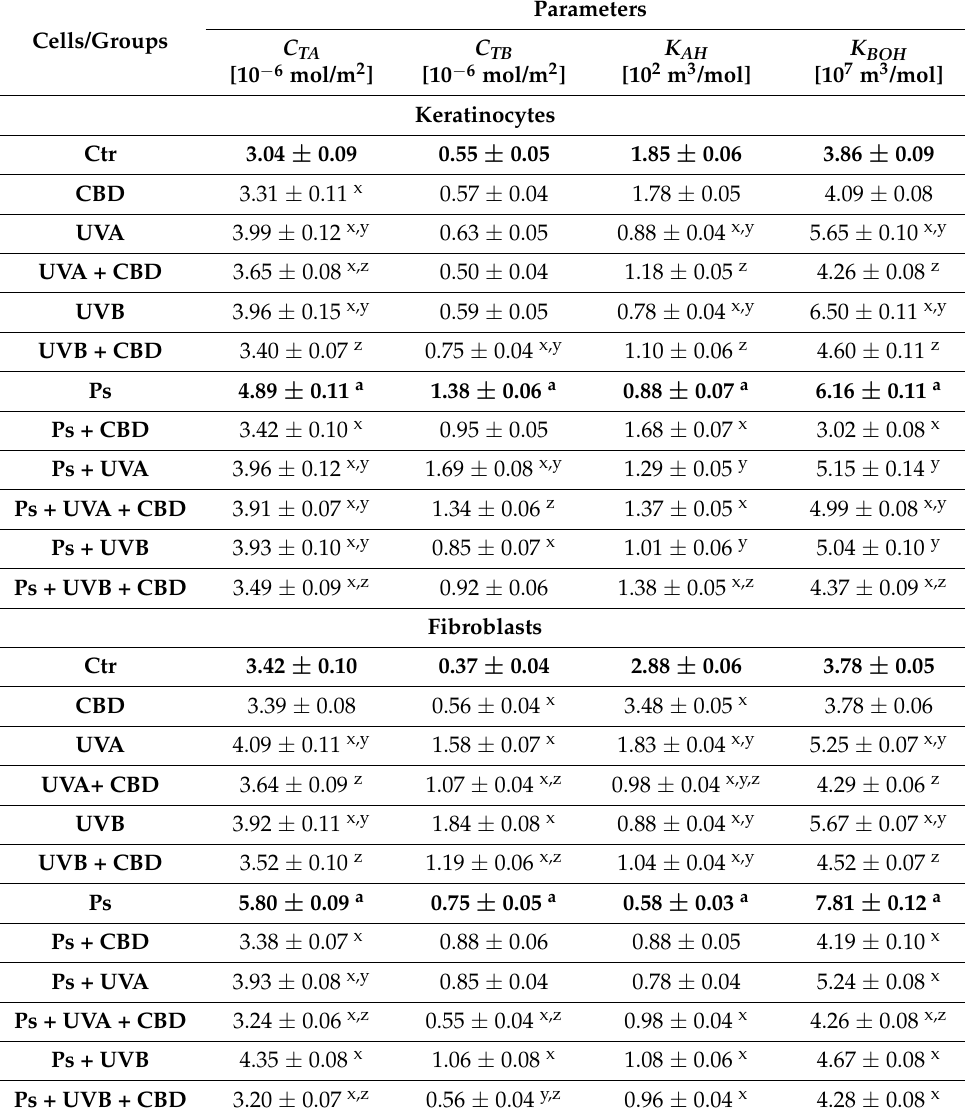
Table 3. The value C TA , C TB , K AH , K BOH of keratinocytes and fibroblasts isolated from skin of healthy subjects (Ctr) ( n = 6) a psoriatic patients (Ps) ( n = 6) exposed to UVA (30 J/cm 2 ) and UVB (60 mJ/cm 2